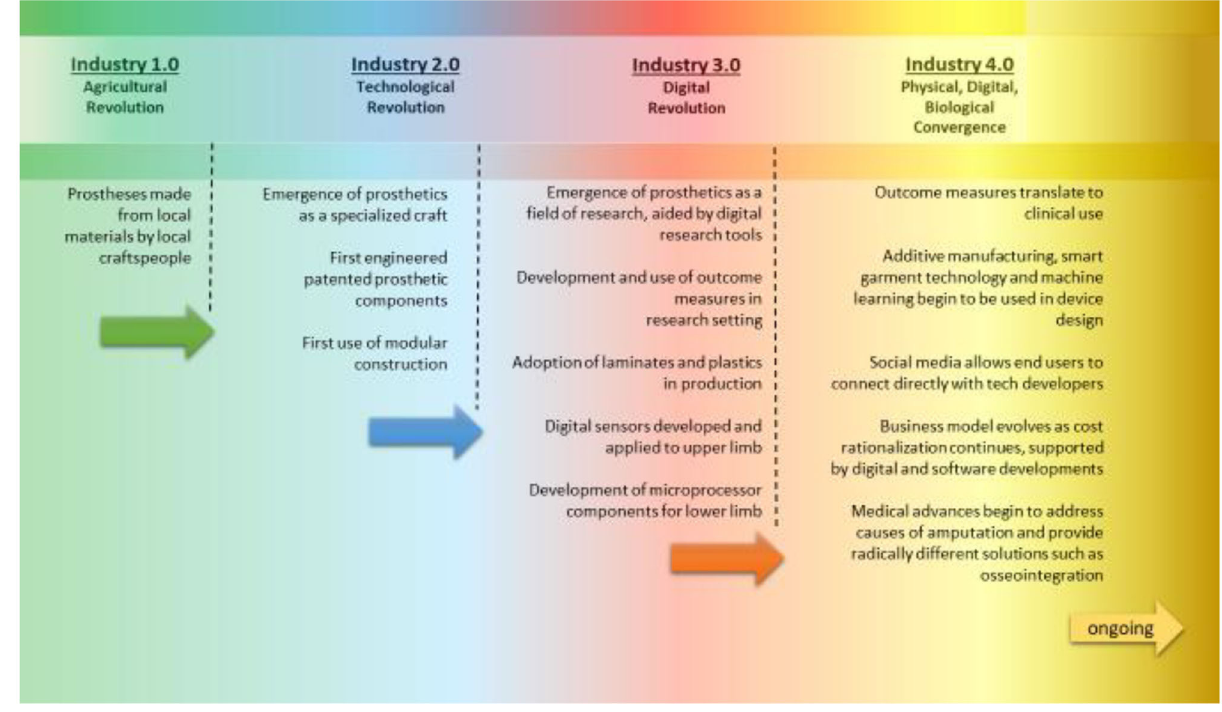
FIGURE 4 | Summary of prosthetic evolution highlights through the